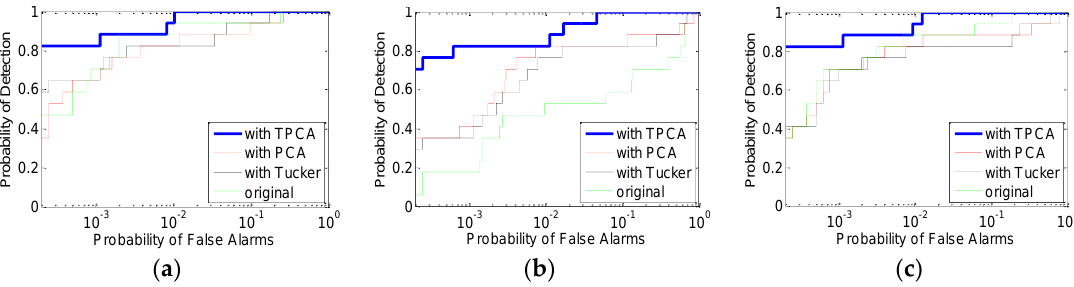
Figure 14. ROC curves with different feature extraction methods for HYDICE data: ( a ) CEM; ( b ) ACE; and ( c ) AMF.